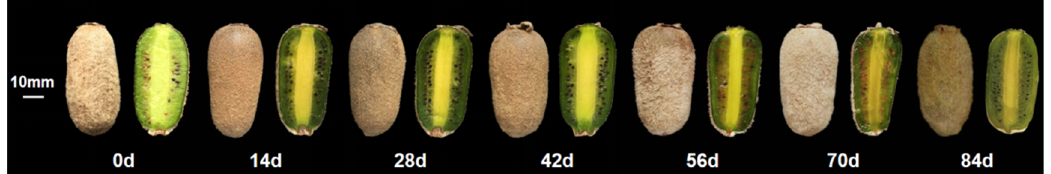
Figure 2. Dynamic changes of on-vine soft ripening